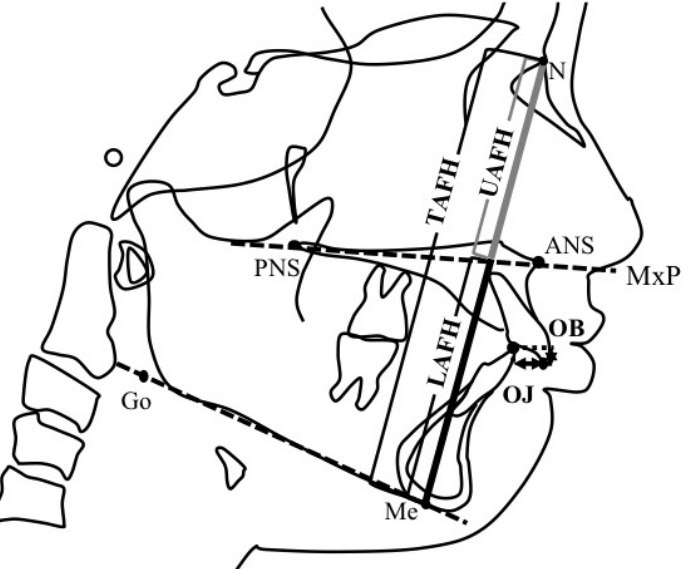
Figure 5. Anatomical planes of reference. N–Me: the plane that connects N and Me. MxP: maxillary plane, the line through ANS and PNS. Overjet (OJ): the horizontal overlap of maxillary incisors over the mandibular incisors (mm). Overbite (OB): the vertical overlap of maxillary incisors over mandibular incisors (mm). UAFH (upper anterior facial height): linear measurement from Nasion to Anterior Nasal Spine (N–ANS). LAFH (Lower anterior facial height): linear measurement from Anterior Nasal Spine to Menton (ANS–Me). TAFH (total anterior facial height): linear measurement from Nasion to Menton (N–Me). Anterior facial height ratio: the ratio calculated between UAFH and LAFH (%).